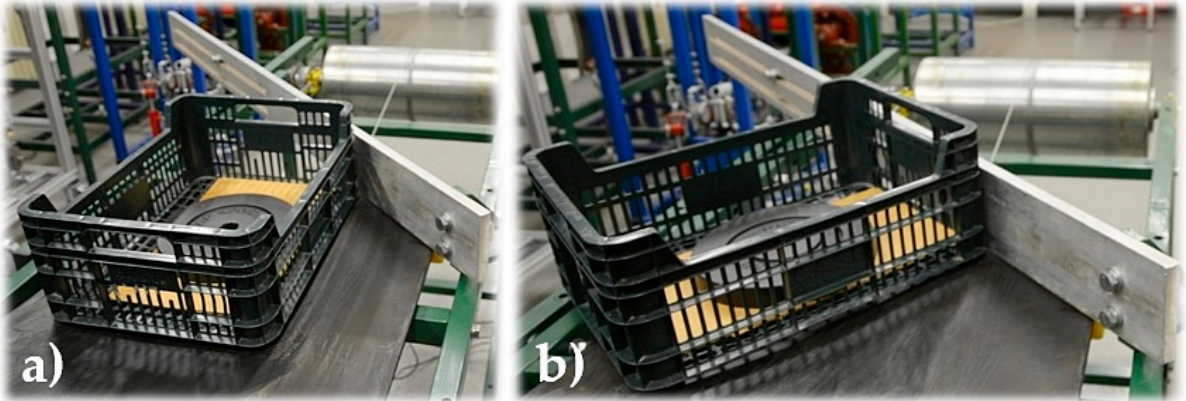
Figure 3. The position of the piece load (plastic crate) during its contact with the scraper plough at the moment of ( a ) phase 1 and beginning of the phase 2, ( b ) at the end of phase 2 and in the course of phase 3.